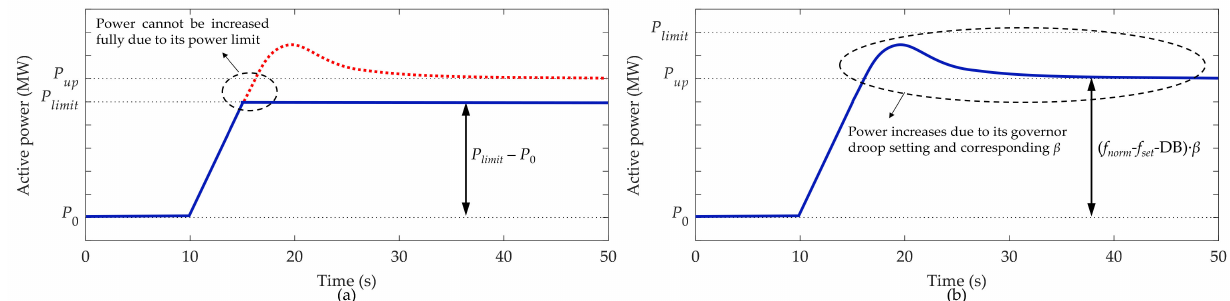
Figure 5. Primary frequency response from SG. ( a ) Limited by power limit, ( b ) PFR provided according to its governor droop coefficient